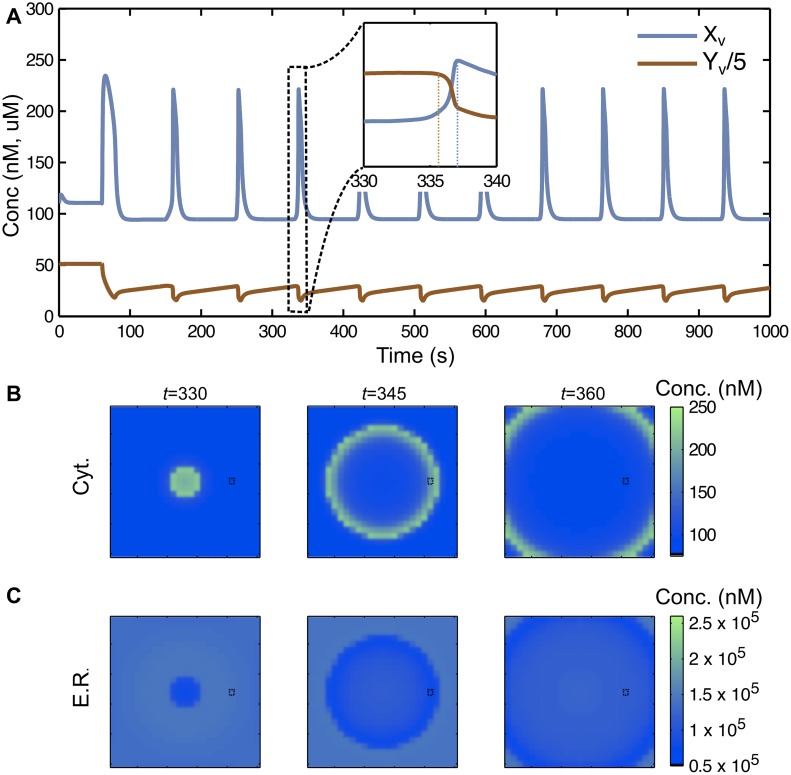
A Ca2+ wave emerges from the zone with highest sensitivity.(A) Fluctuations in ccyt (blue) and cER (orange) of one particular cell. (B) Evolution of the wave between time t = 330 and t = 360. The panel (A) corresponds to the oscillations of a particular cell (black square). (C) Evolution in the ER component. The central region has parameters set to iJINF,max,1 = 1.08, iIP3,max,1 = 2.16 and t1,1 = 72. The gap junctional coupling is moderate/low (d = 0.003).